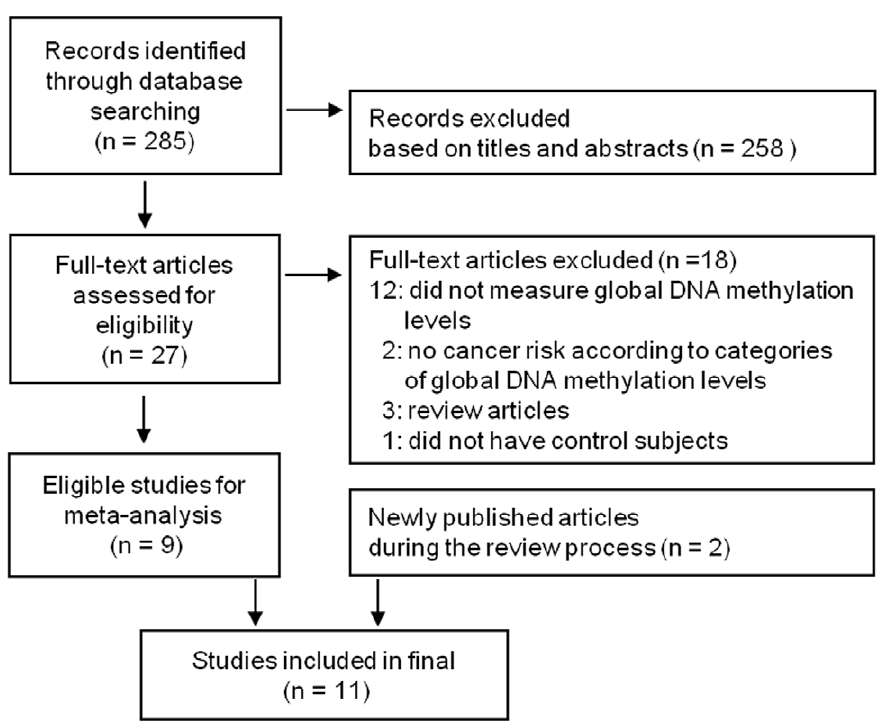
Figure 1. Flow diagram of study selection.